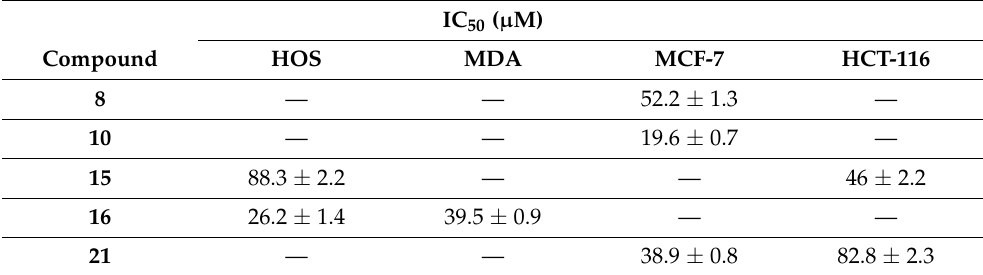
Figure 3. In vitro cytotoxic screening (%) of the newly synthesized coumarin derivatives upon normal human cell lines (BJ-1) at 100 μM; each result is a mean of three replicate samples, and values are represented as % inhibition. Table 2. IC 50 values (μM) of active coumarin derivatives 8 , 10 , 15 , 16 and 21 having ≥60% cytotoxicity over their corresponding cancer cell lines.